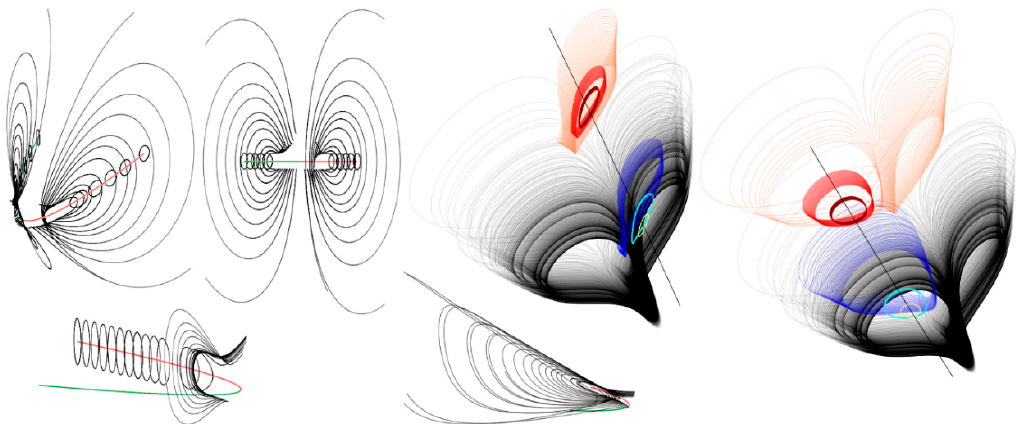
Figure 2. Two different 3D views of the local geometry of dynamical flow in the close neighborhood of the hyperbolic equilibrium; the hyperbolic curve is split into two parts shown as a colored curve: y > 0 (red) and y < 0 (green), locations of periodic solution with respect to the chaotic attractor and equilibrium.